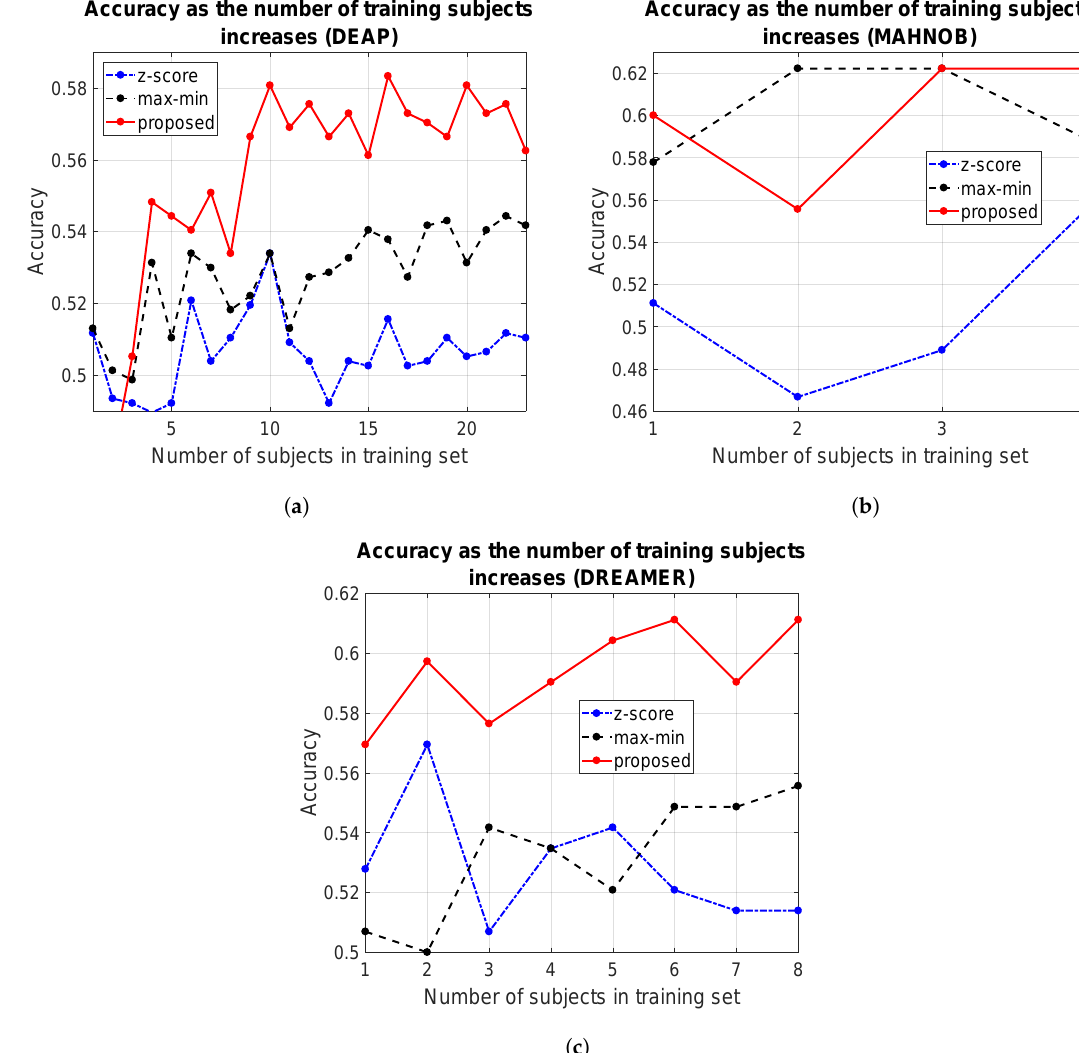
Figure 5. Classification accuracy as the number of training users is increased: ( a ) DEAP; ( b ) MAHNOB-HCI; and ( c )